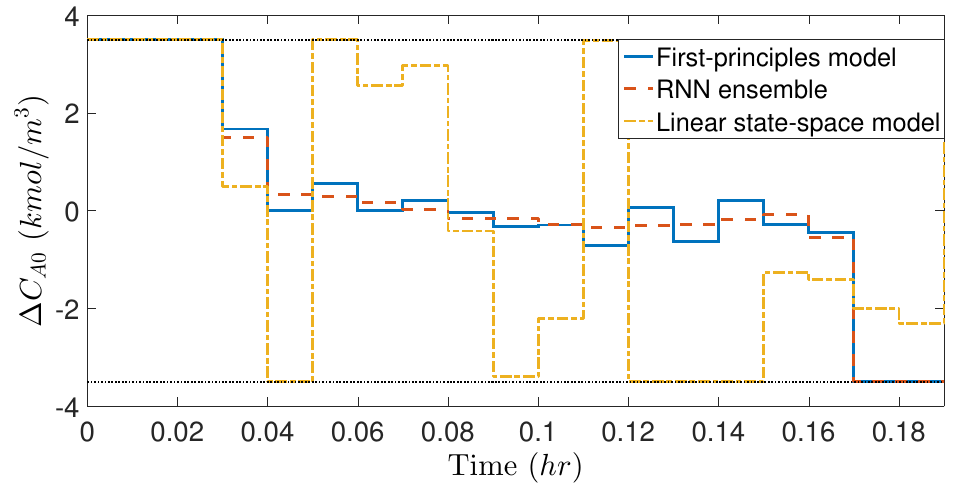
Figure 7. Manipulated input profiles ( u 1 = ∆ C A 0 ) for the initial condition (0, 0) under the LEMPC using the following models: the first-principles model (blue trajectory), the RNN model ensemble (red trajectory) and the linear state-space model (yellow trajectory), where the dashed black horizontal lines represent the upper and lower bounds for ∆ C A 0